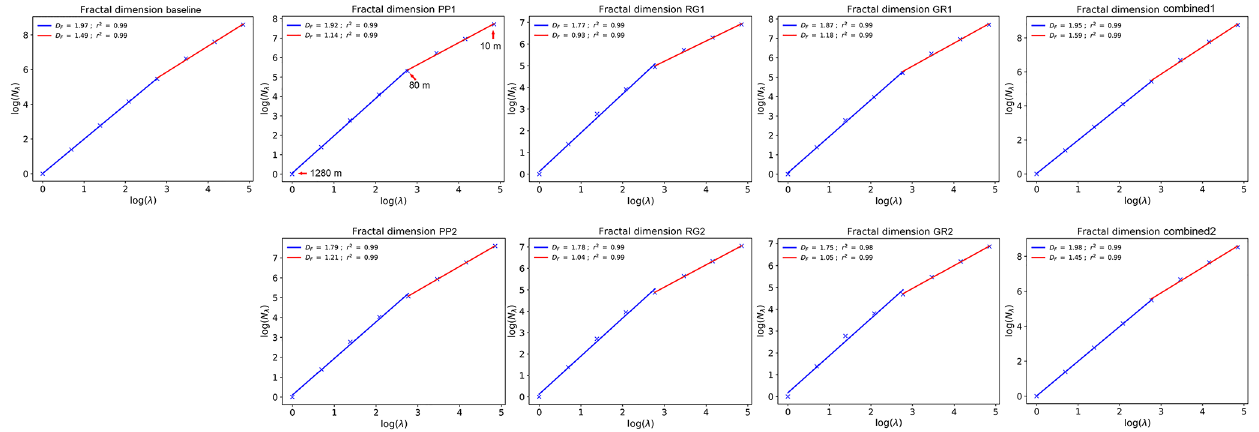
Figure 7. The fractal dimension of impervious surface of the baseline scenario and the fractal dimension of NBSs in each NBS scenario.